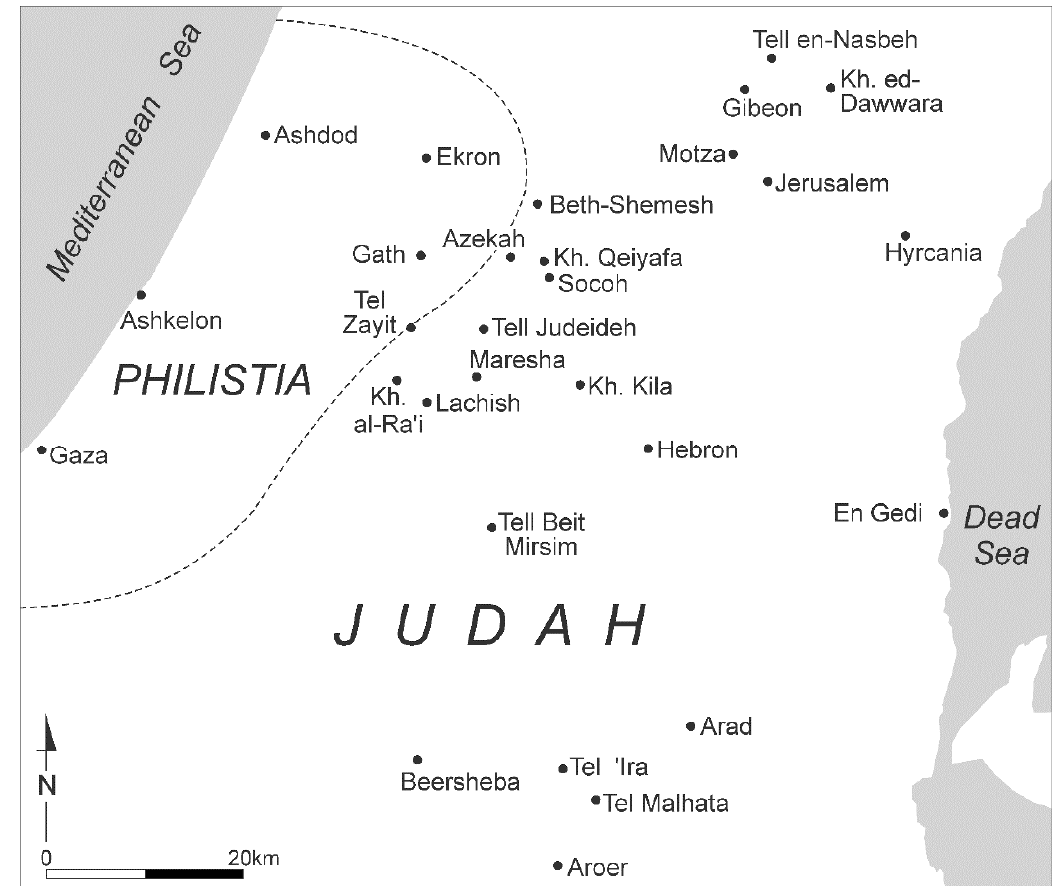
Figure 1. The Kingdom of Judah and the location of sites mentioned in the text.